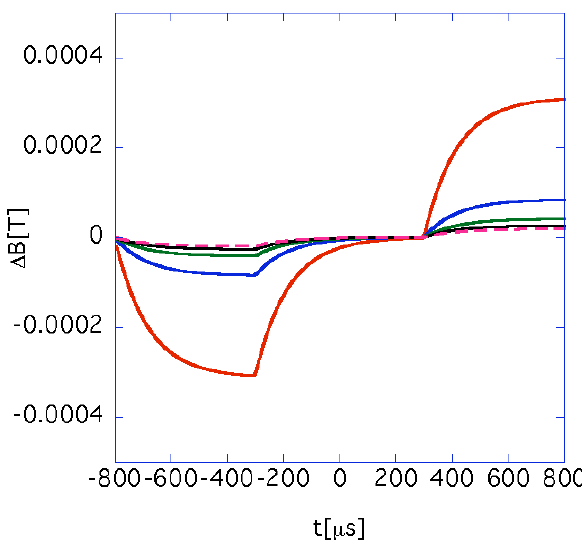
FIG. 15. (Color) The dependence of the field modulation (theo- retical results) on the size of magnet yoke where the chamber is completely surrounded by Cu stripes ( N ¼ 100 ). The red, blue, green, black, and pink dotted lines represent the cases where both the gap height g and the width h is equal to a ð the radius of the chamber Þ þ b ð the radius of the Cu stripe Þ , where both g and h are 2 times larger than a , where both g and h are 3 times larger than a , where both g and h are 4 times larger than a and where both g and h are 5 times larger than a ,